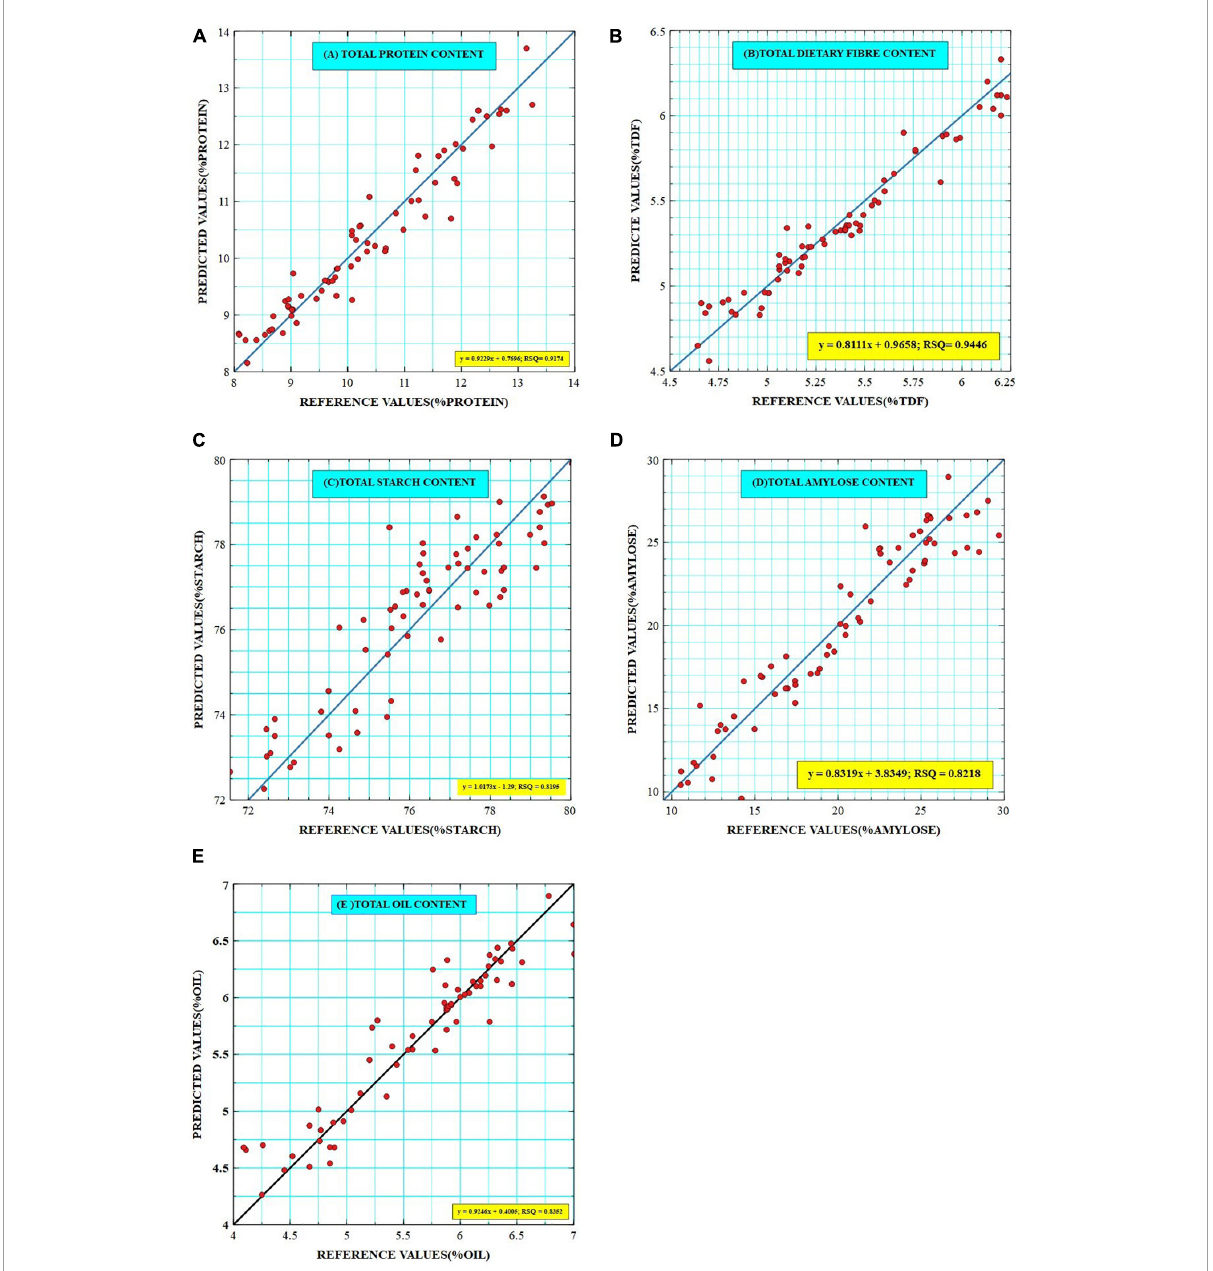
FIGURE3 Scatter plots of reference and predicted values of (A) Total Protein, (B) Total Dietary Fiber, (C) Total Starch, (D) Total Amylose, and (E) Total Oil contents as generated by Veusz software. The key represents a linear equation with RSQ values for each trait.